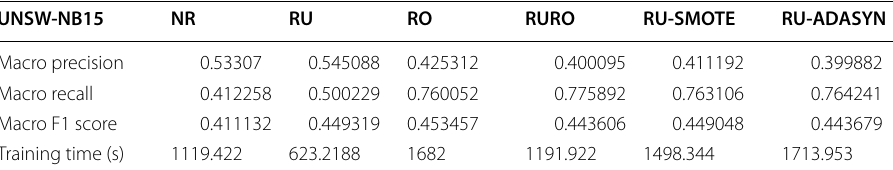
Table 21 ANN classification results for UNSW-NB15 on local machine for various resampling methods